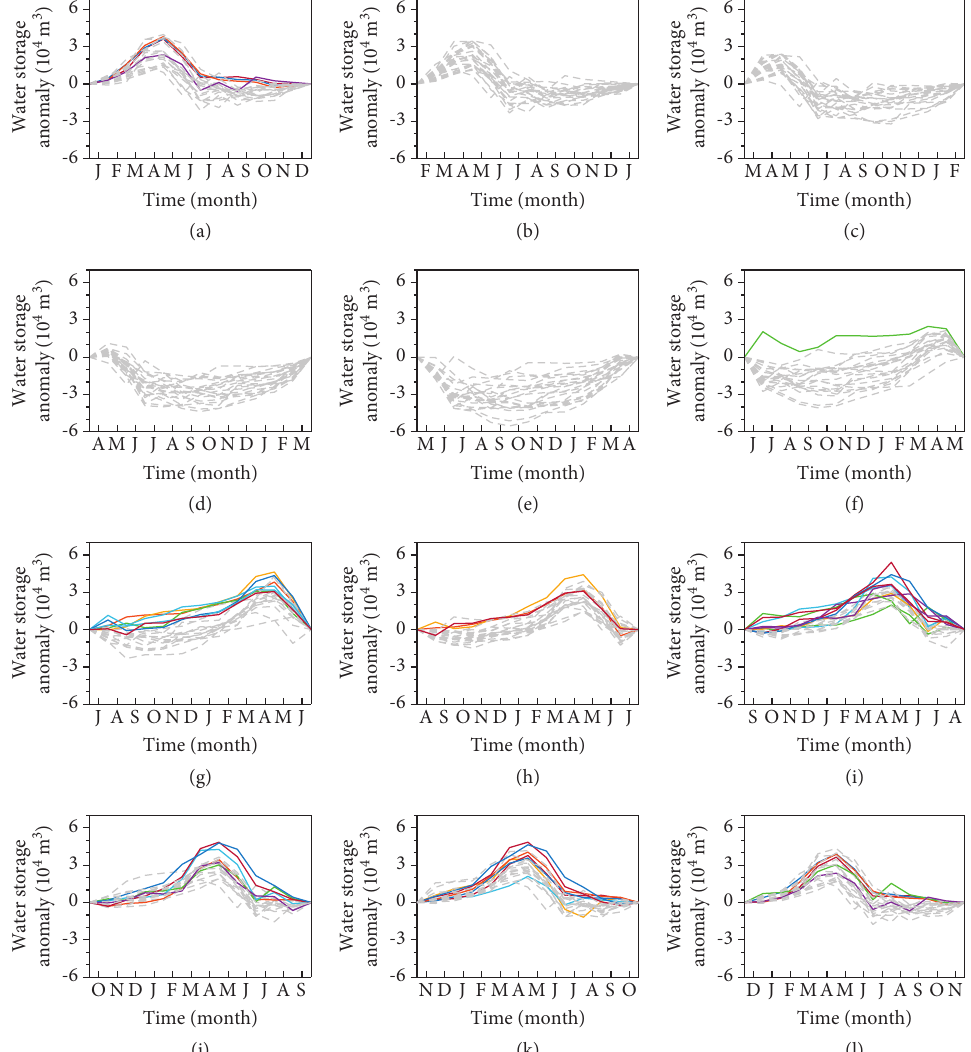
Figure 8: Water storage anomaly for different 12-month regulating cycles in the SSP370 scenario from 2061 to 2100. The curves for damage years (negative storage anomaly for more than two months) are shown by gray dash lines while undamaged years by color solid lines (colors are only used to distinguish multiple lines). (a–l) Regulating cycles start from January to December. Table 5: Three representative hydrological years under different regulation cycles for five models. Regulation